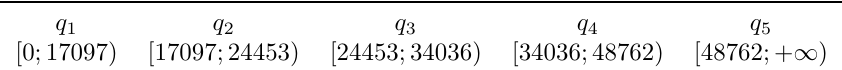
Income classes for Italian families